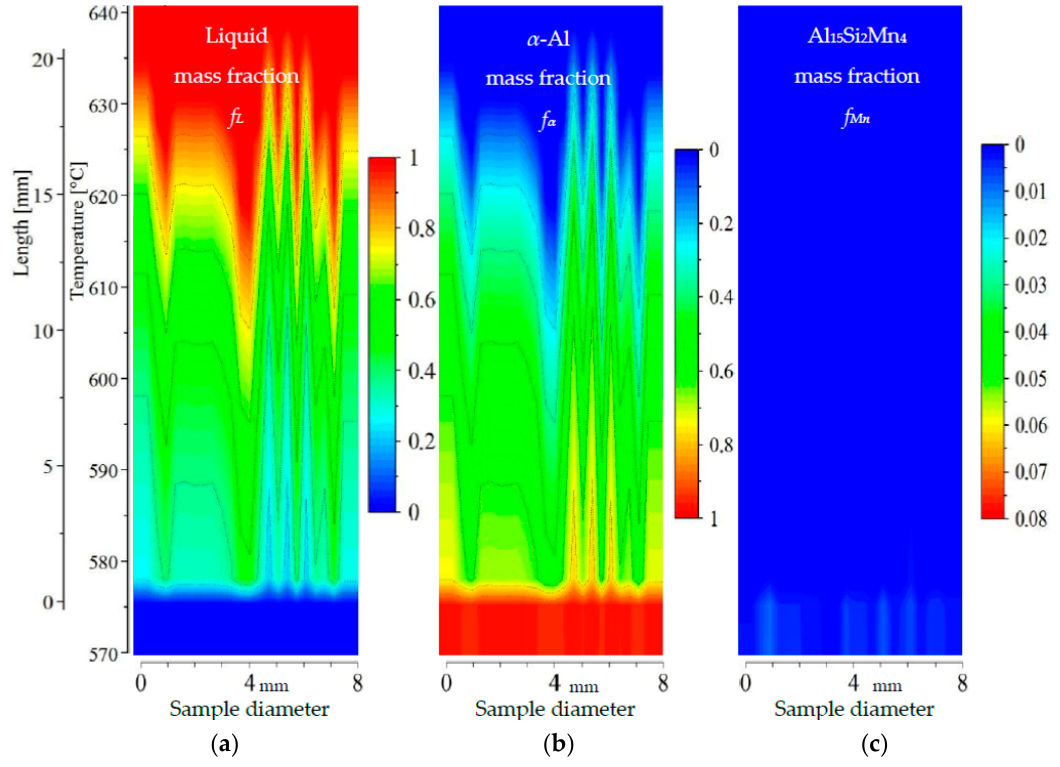
Figure 9. 2D maps of mushy zone for AlSi5Mn0.2 specimen: ( a ) liquid mass fraction f L ; ( b ) α -Al mass fraction f α ; ( c ) Al 15 Si 2 Mn 4 mass fraction f Mn in function of sample diameter and temperature/sample length.